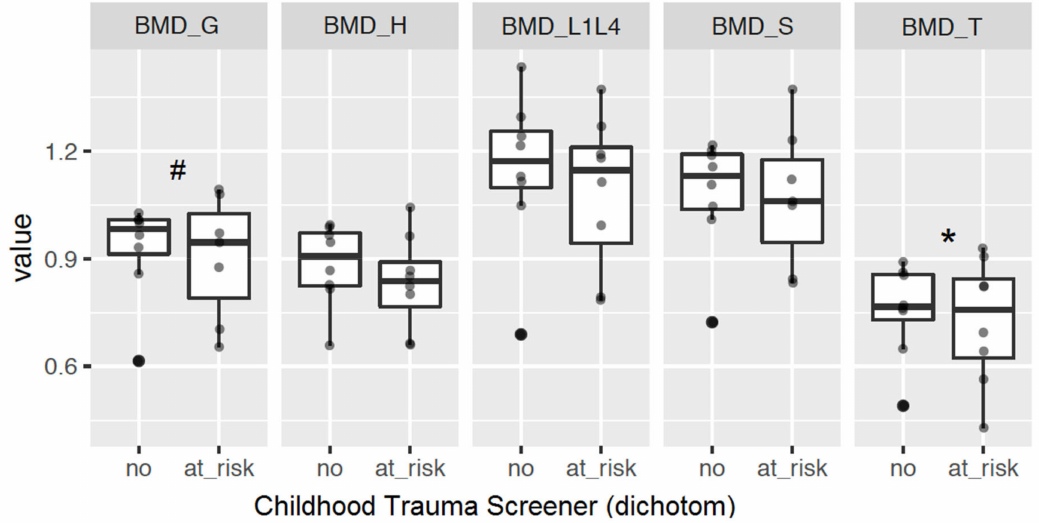
Figure 6. Bone mineral density measurements in human patients. Shown is the bone mineral density (BMD) in G (total), H (collum femoris), S (corpus femoris), and T (trochanter major) as mean of the right and left site and L1-L4 (lumbar vertebralis bodies) stratified for at risk and not at risk for childhood maltreatment (not controlled for gender, age, body weight). Data ( n = 18) are expressed as mean and standard deviation of BMD, stratified for Childhood Trauma Screener (CTS) (at risk for abuse or neglect). Significance level: * p < 0.05, and # p < 0.1 between indicated